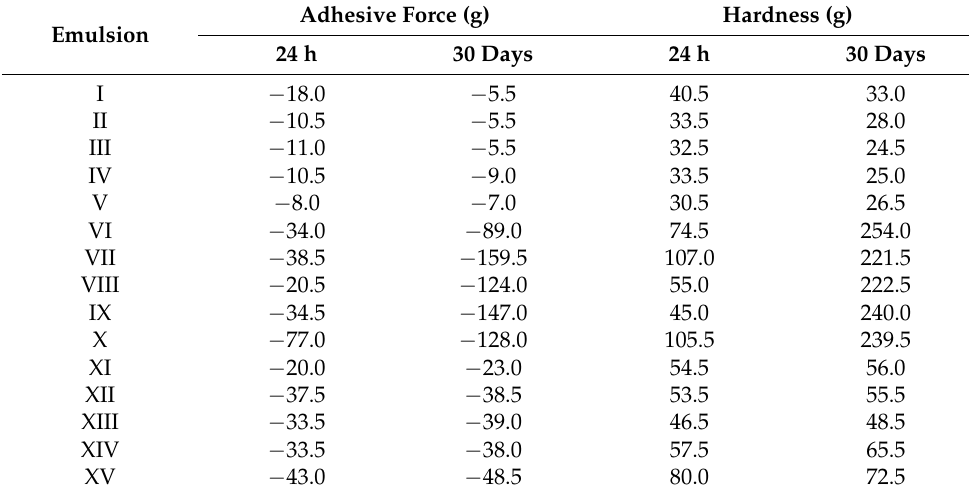
Table 3. Emulsion texture at 24 h and 30 days after preparation of the systems.